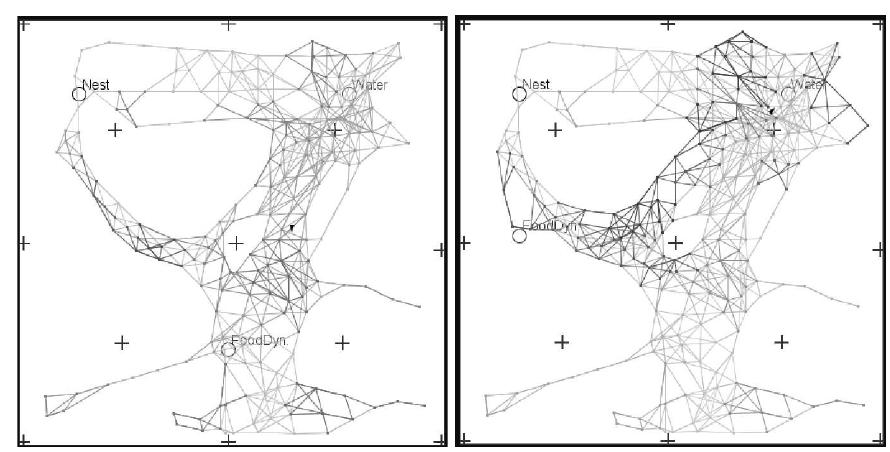
Figure 7. Cognitive map evolution induced by a changing environment. The roads leading to the food source in the left snapshot (bottom of figure) of the cognitive map are partially forgotten when the source has changed, whereas new paths have appeared near the new source location (left part of the right snapshot of the cognitive map) and some existing paths have been reinforced (in this experiment, the animat almost never goes directly from Nest to Water, but prefers to “transit” by the Food source)